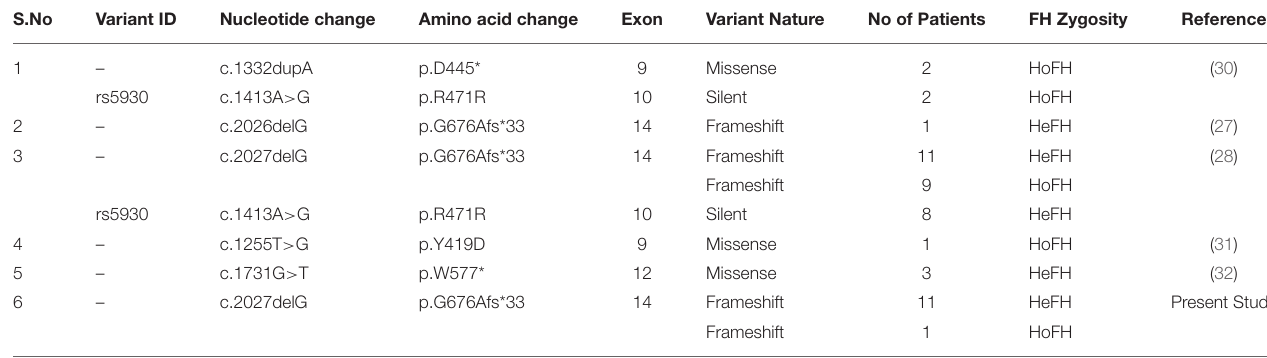
TABLE 2 | LDLR variants reported in Saudi FH